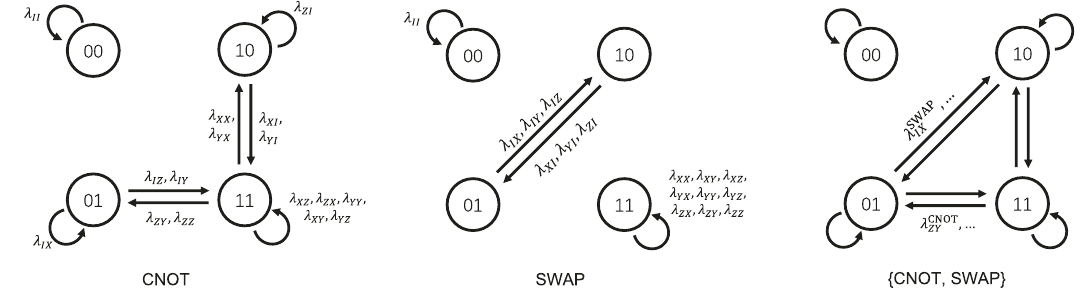
omit the superscripts of CNOT or SWAP. The labels on the last graph are a com- bination of the fi rst two graphs and are omitted for